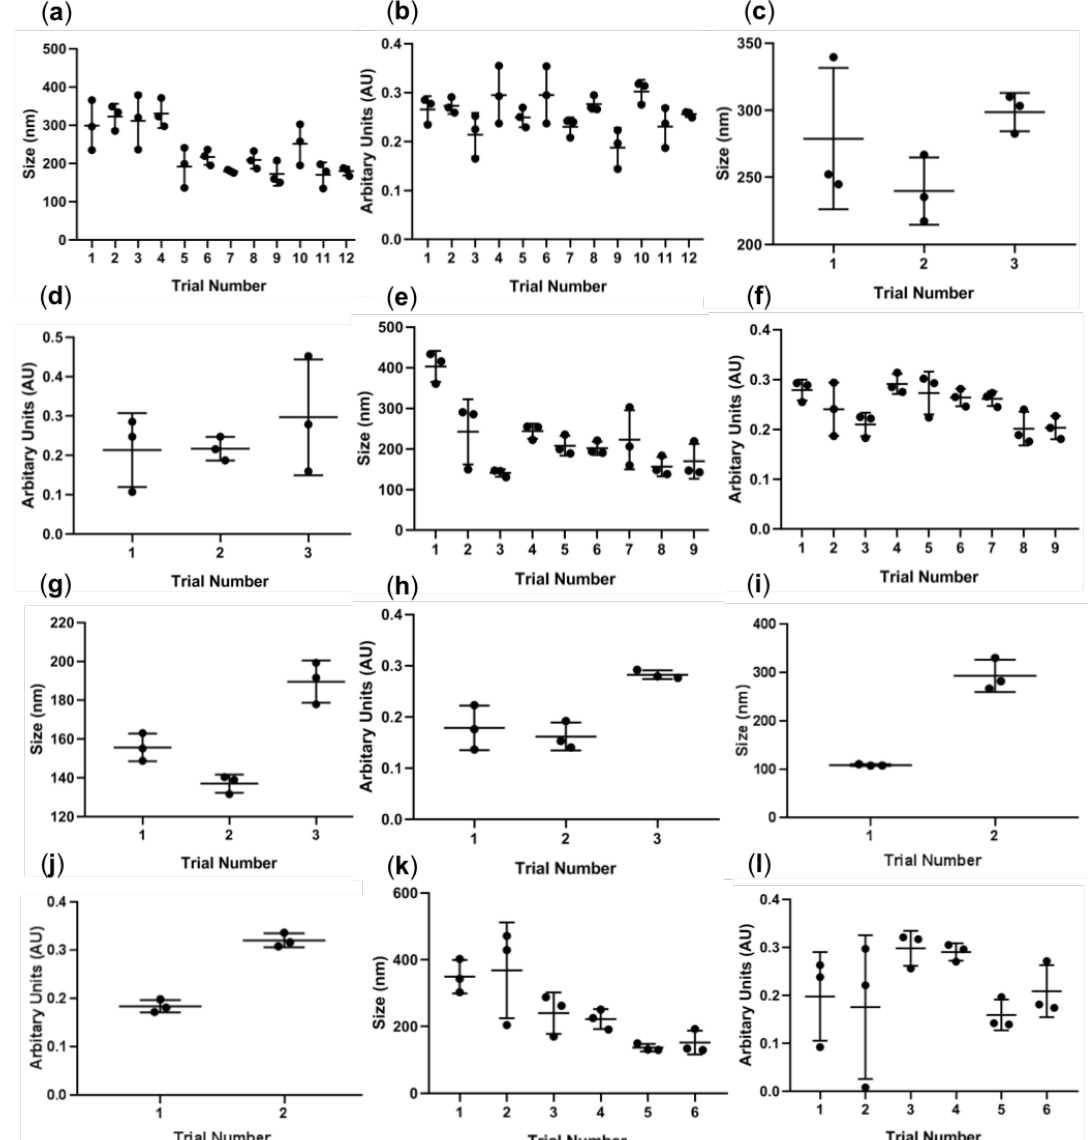
Figure A3. The batch-to-batch consistency between trials: ( a ) the diameter of Zein nanoparticles (NPs) using a syringe pump synthesis under standard conditions, n = 36; ( b ) the polydispersity (PD) of Zein NPs using a syringe pump synthesis under standard conditions, n = 36; ( c ) the diameter of Zein NPs using a syringe pump synthesis under standard conditions with stabilizers [0.5% Tween 80 (TW80) 1.0% Pluronic F-68 (PF-68)], n = 9; ( d ) the PD of Zein NPs using a syringe pump synthesis under standard conditions with stabilizers (0.5% TW80 1.0% P-F68), n = 9; ( e ) the diameter of Zein NPs using a syringe pump synthesis under standard conditions other than relative flow rate (RFR) [RFR 1:5], n = 27; ( f ) the PD of Zein NPs using a syringe pump synthesis under standard conditions other than RFR [RFR 1:5], n = 27; ( g ) the diameter of Zein NPs using a syringe pump synthesis under standard conditions other than RFR [RFR 1:5] with stabilizers (0.5% TW80 1.0% PF-68), n = 9; ( h ) the PD of Zein NPs using a syringe pump synthesis under standard conditions other than RFR [RFR 1:5] with stabilizers (0.5% TW80 1.0% P-F68), n = 9; ( i ) the diameter of Zein NPs using a batch synthesis method, n = 2; ( j ) the PD of Zein NPs using a batch synthesis method, n = 2; ( k ) the diameter of Zein NPs using a syringe pump synthesis with a T-Junction under standard conditions, n = 9; and ( l ) the PD of Zein NPs using a syringe pump synthesis with a T-Junction under standard conditions, n = 9.